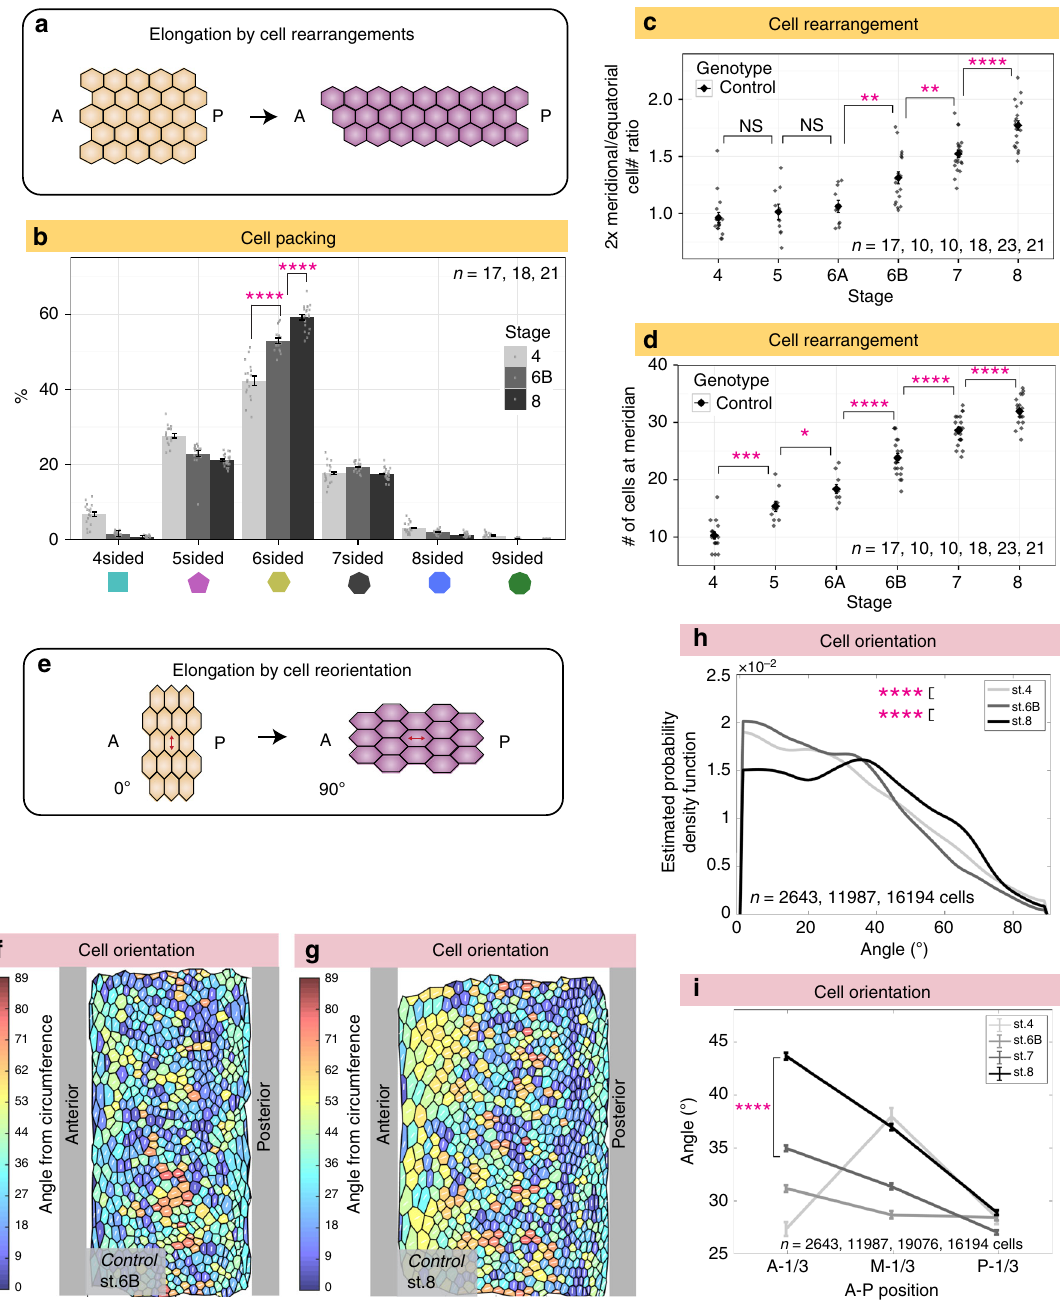
Fig. 4 Cell rearrangements and cell reorientation in elongating wild-type follicles. a Schematic of tissue elongation via cell rearrangements. b Quantitation shows increases in topological order (i.e. fraction of hexagonal cells) from stage 4 to stage 8. P values = 6.7e-08 and 2.8e-07; two-sided Welch ’ s t test. n , biologically independent samples. c Cell counts along two arcs demonstrate increases in the ratio of meridional cells to equatorial cells from stage 6B through stage 8. Meridional cell number, de fi ned in Fig. 1g, is doubled on the y axis in ( c ) to capture entire follicle perimeter, as does the equatorial cell number. P values = 0.55, 0.58, 0.003, 0.0024, and 2.2e-05; two-sided Welch ’ s t test. n , biologically independent samples. d Increases in the number of meridional cells also demonstrate cell intercalation. P values = 1.8e-04, 0.02, 7.8e-05, 2.0e-05, and 4.2e-05; two-sided Welch ’ s t test. n , biologically independent samples. e Schematic of tissue elongation via cell reorientation: anisotropically-shaped cells remodel cell junctions to shift the direction of their long axis. f , g ImSAnE cylinder projections of stage 6B and stage 8 follicles, color-coded for cell orientation (0° = latitudinal; 90° = A – P). h Graph showing distribution of cell orientations in wild-type follicles: estimated probability density function ( y axis) re fl ects the relative frequency of cells with a given long axis orientation ( x axis, as de fi ned in ( e )). From stage 4 – 8, the proportion of A – P-oriented cells increases signi fi cantly. P values = 2.0e-05 and 3.27e-83; Two-sample Kolmogorov – Smirnov test. n = number of follicle cells. i Cells in the anterior one-third of the follicle between stage 6B and 8 reorient to become increasingly A-P oriented (A-1/3: anterior one-third; M-1/3: middle one-third; P-1/3: posterior one-third; values are mean orientation for each region). P value = 4.22e-86; two-sided Welch ’ s t test. n = number of follicle cells. Error bars, s.e.m. NS not signi fi cant, * P < 0.5, ** P < 0.01, ** P <